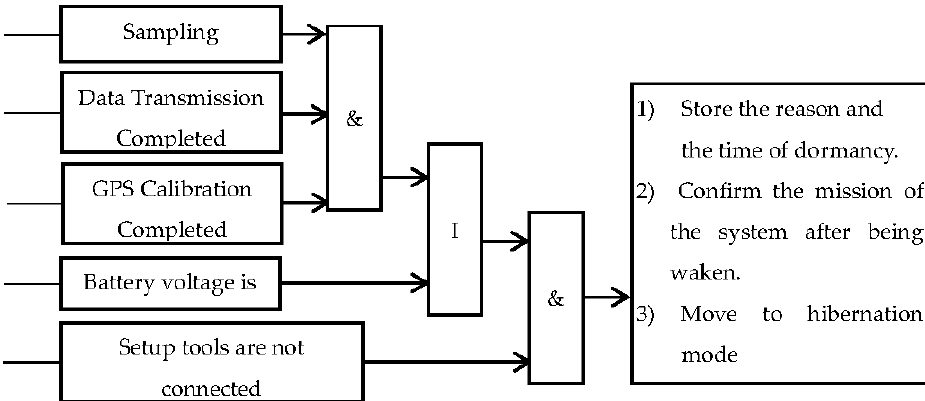
Figure 2. Low power consumption and the logic of management and control in the ZKOS.